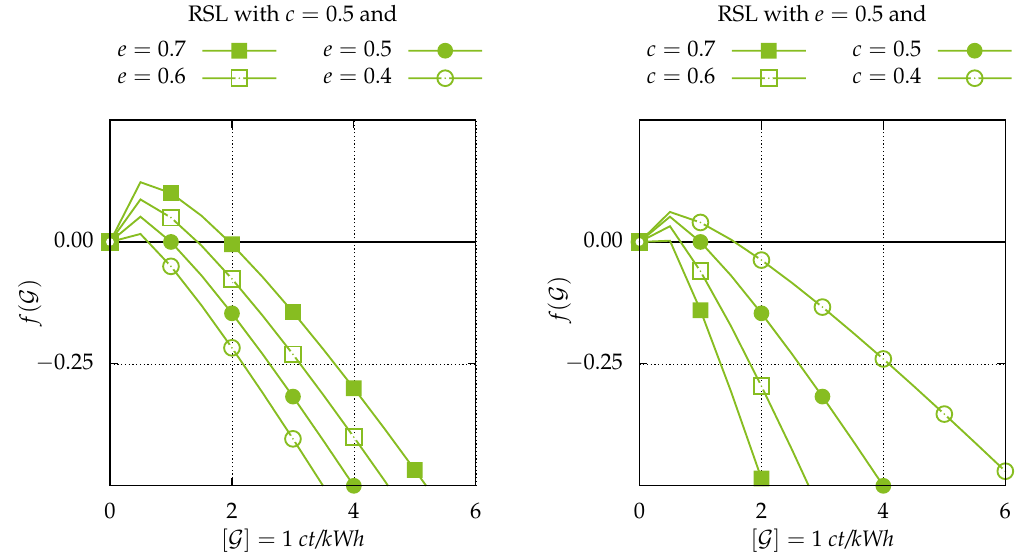
Figure 5. Preference of different RSL types for green over grey